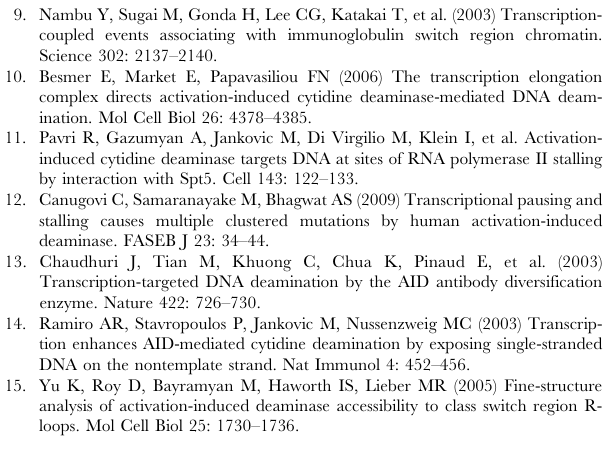
Figure S1 Comparative analysis of Leu + chromosomal tranlo- cations in hpr1 D cells overexpressing AID in the presence of S m 350